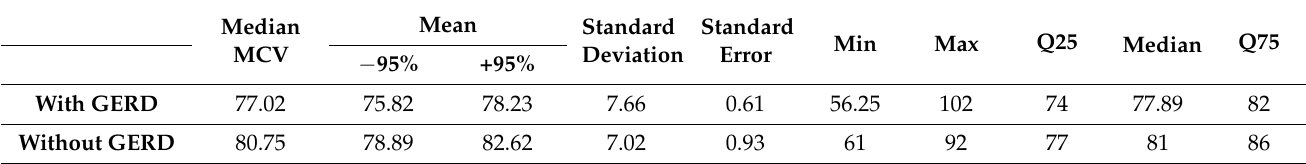
Table 5. Statistical indicators for MCV in relation to GERD.